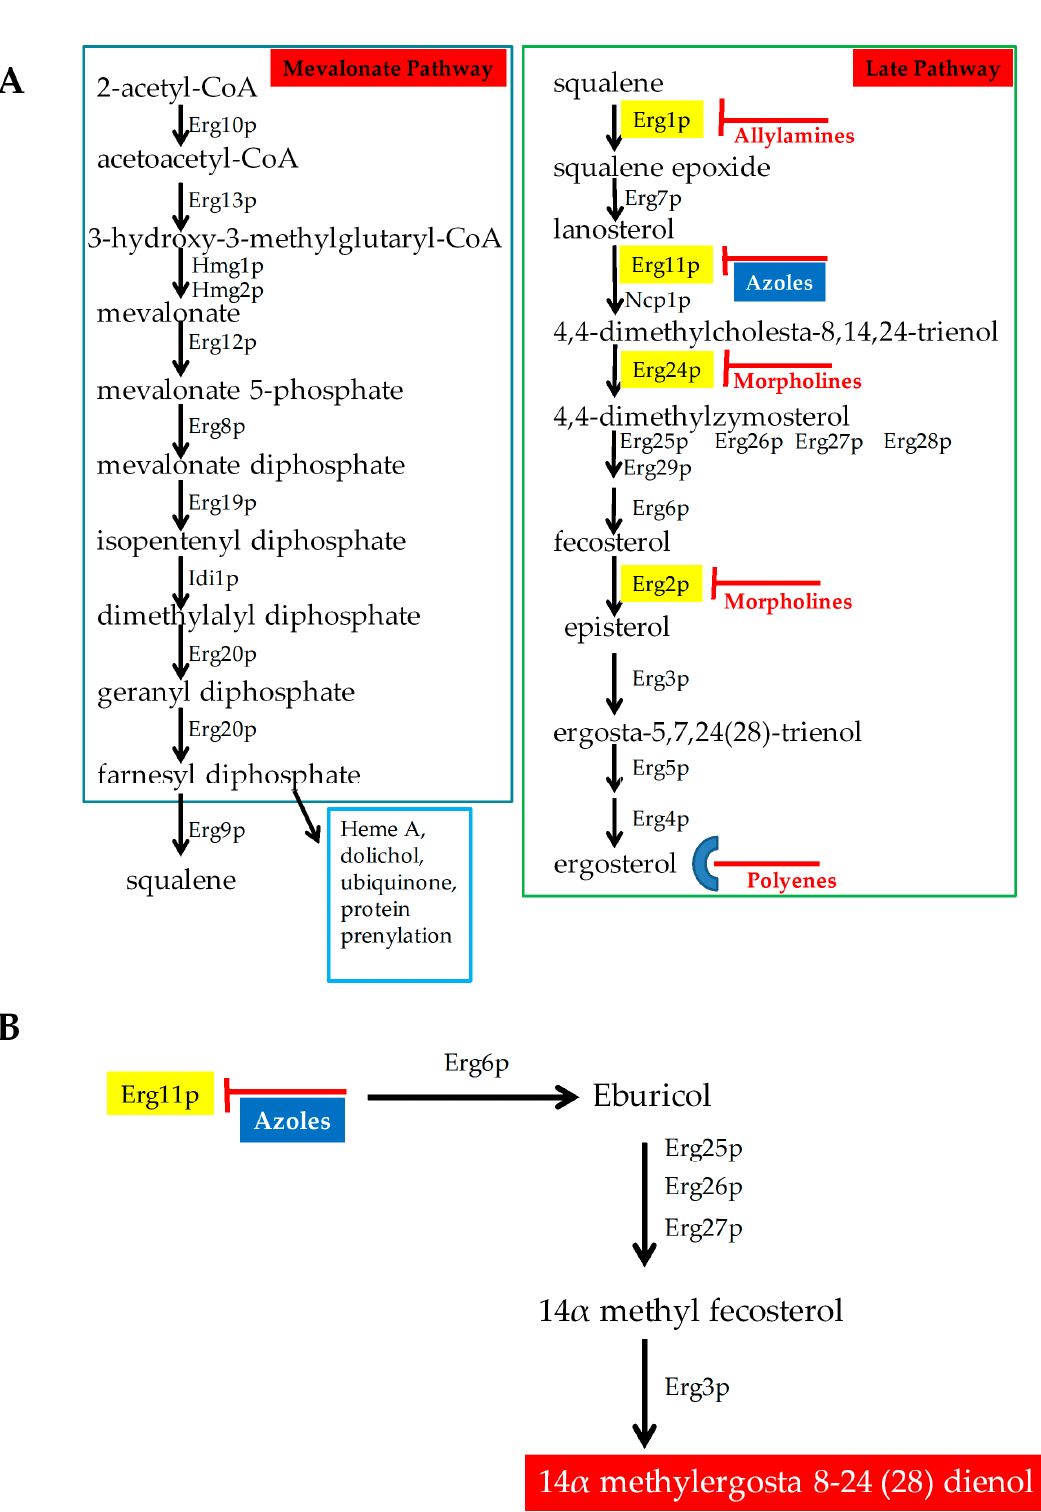
Figure 1. Antifungals that target ergosterol and its biosynthesis. ( A ) Ergosterol biosynthetic Pathway with different antifungals targeting different enzymes in the pathway. ( B ) Mechanism of action of azole antifungals.